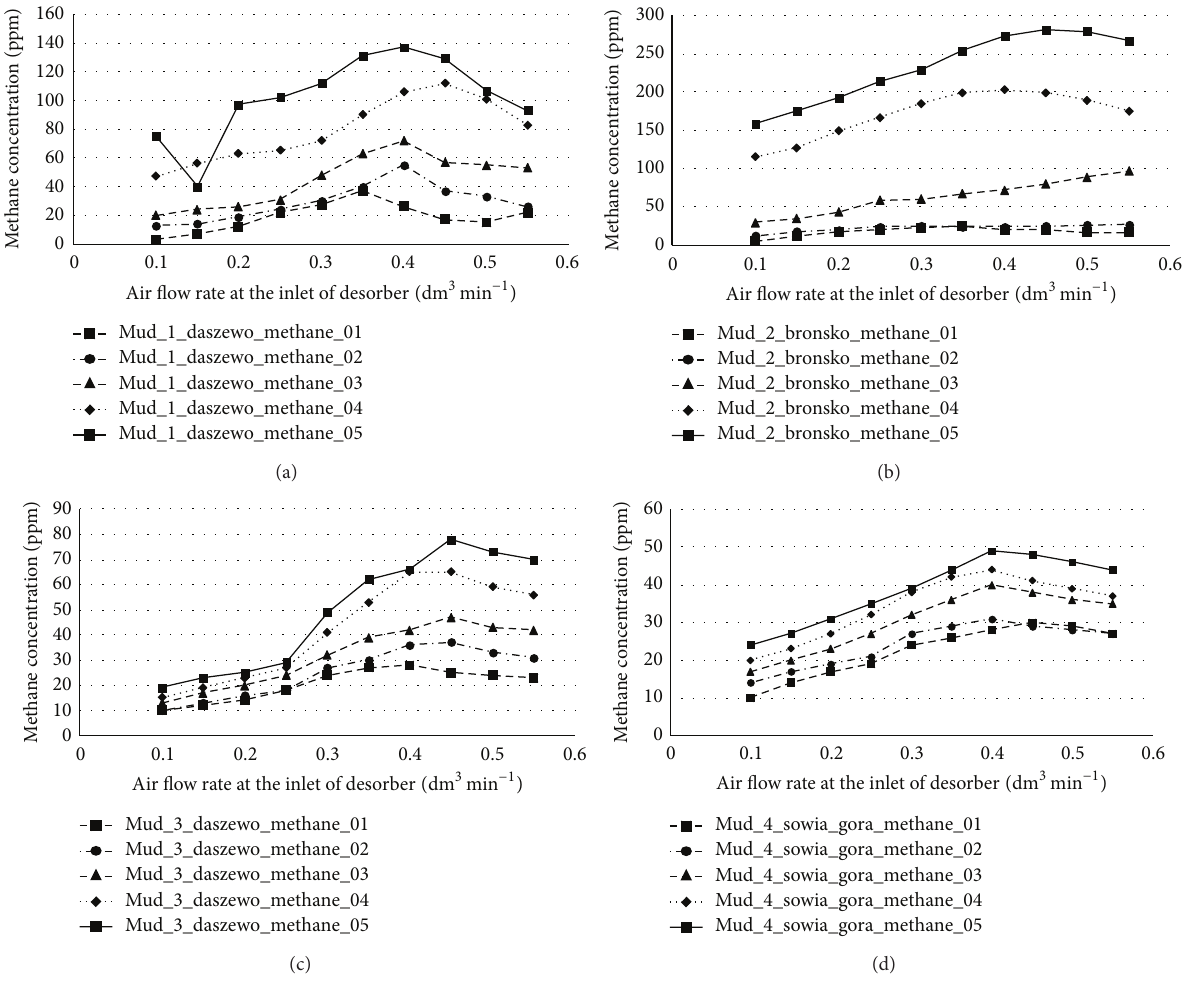
Figure8:Thegasconcentrationofmethaneinthefunctionofairflow(dm 3 min −1 )attheinletofthedesorberfordifferentmethanesaturation of drilling mud from (a) Daszewo borehole (density 2.06 kg dm −3 ), (b) Bro´nsko borehole (1.67 kgdm −3 ), (c) Daszewo borehole (1.18kg dm −3 ), and (d) Sowia G´ora borehole (1.08kg dm −3